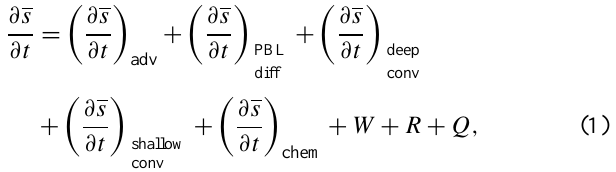
Fig. 1. Sub-grid processes involved in trace gas emissions, trans- Figure 1: Sub-grid processes involved in trace gas emissions, transport, transformation and port, transformation and deposition as simulated by the Chemistry deposition as simulated by the Chemistry – CATT-BRAMS system. CATT-BRAMS